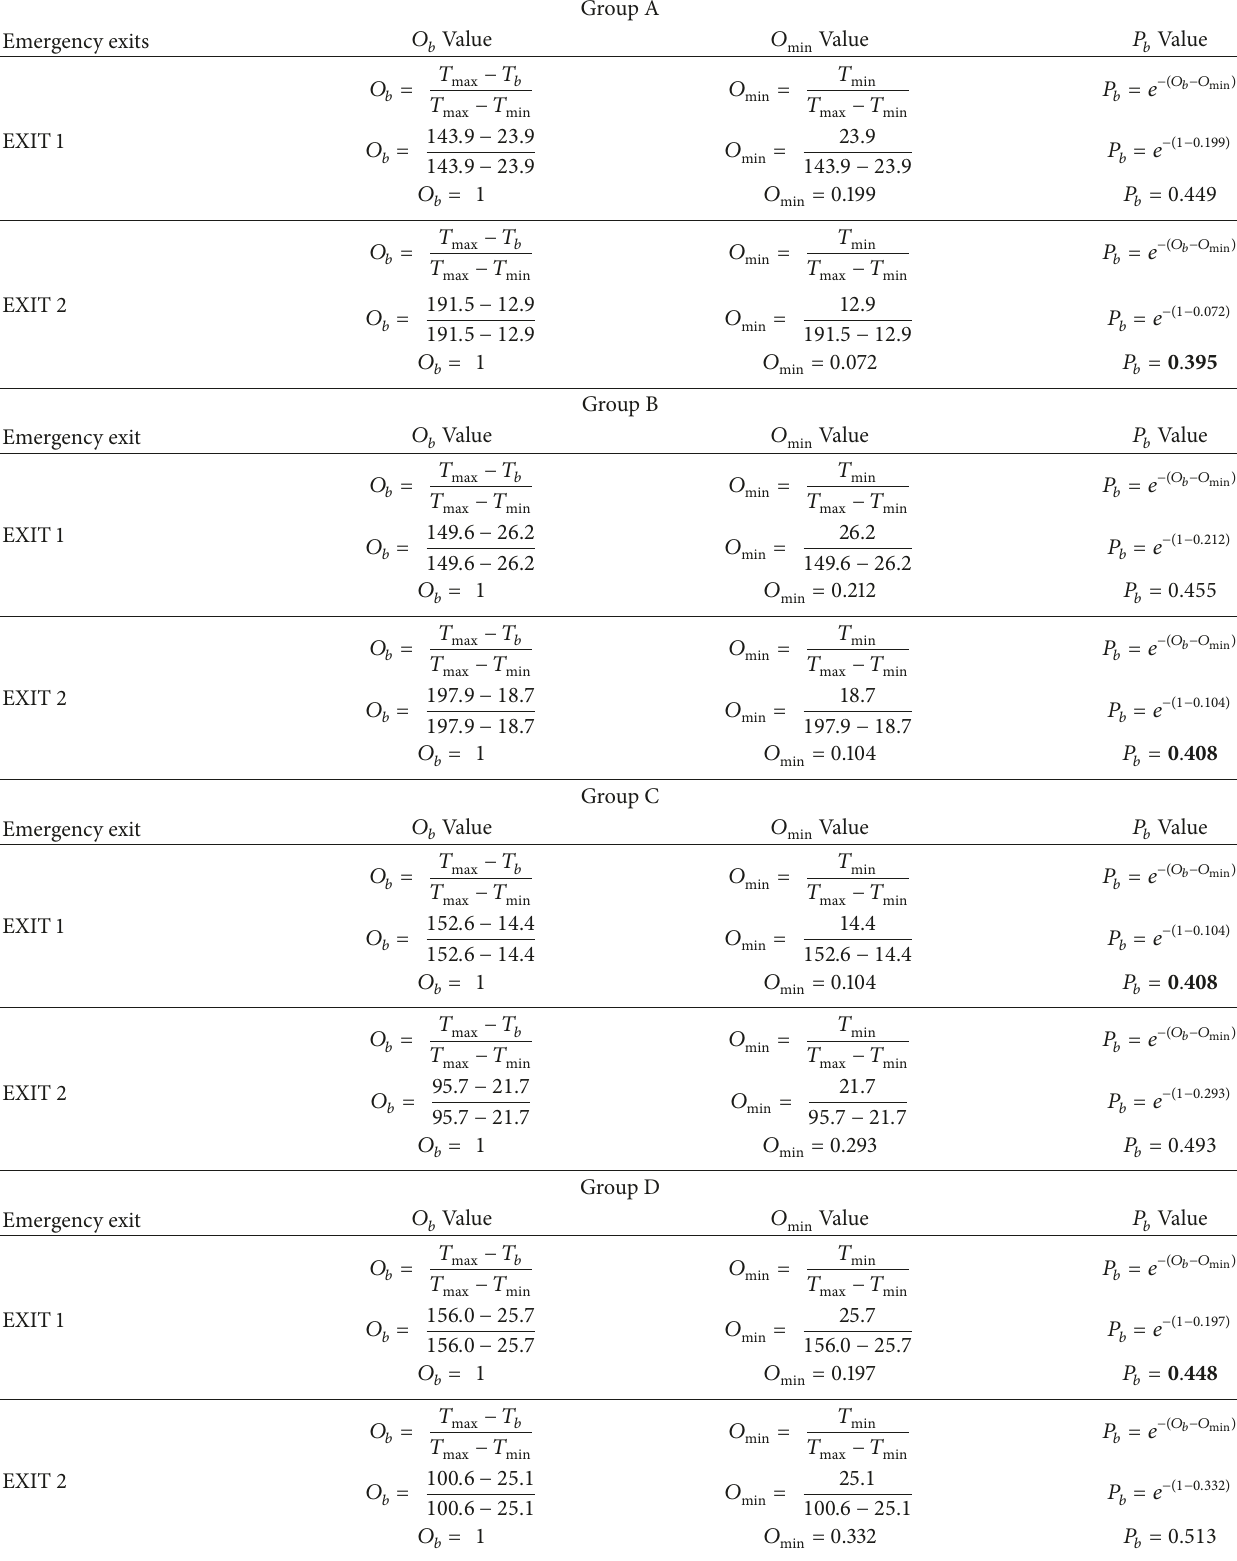
Table 4: Calculations of 𝑂 𝑏 and 𝑃 𝑏 values for evacuees groups A to